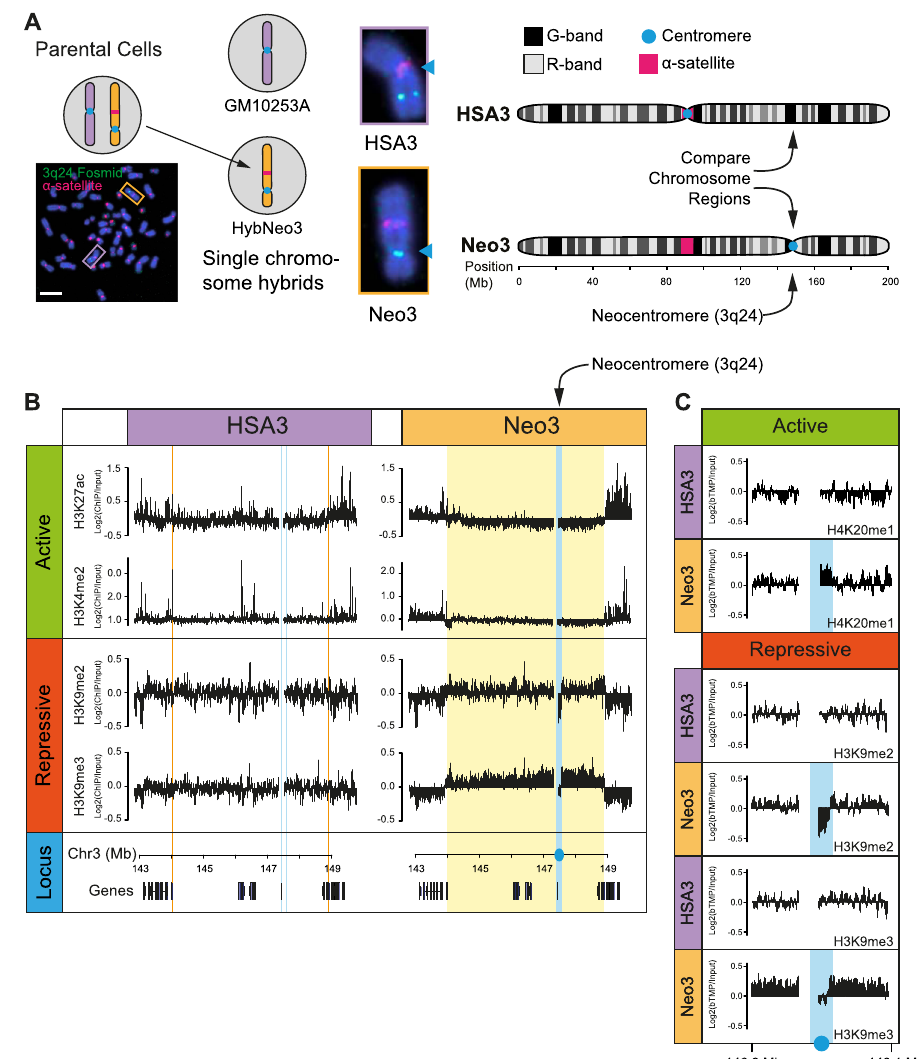
Fig. 1 | Epigenetic remodelling after centromere repositioning. A Schematic detailing experimental model system. Left; human lymphoblastoid cells (Parental) harbouring a canonical human chromosome 3 (HSA3; purple frame) and a chro- mosome 3 with a neocentromere located at 3q24 (Neo3; orange frame) were genetically manipulated to isolate Neo3 in a human-hamster hybrid (HybNeo3) for comparison to a human-hamster hybrid (GM10253A) with a single HSA3 chromo- some. Middle, DNA FISH with α -satellite speci fi c probe (red) and a fosmid probe (green) for 3q24. The primary constriction (arrow) coincides with the α -satellite array in HSA3 but is located at 3q24 in Neo3. Chromosomes were counterstained with DAPI. The bar is 5 µ m. Right, chromosome 3 ideogram indicating the 3q24